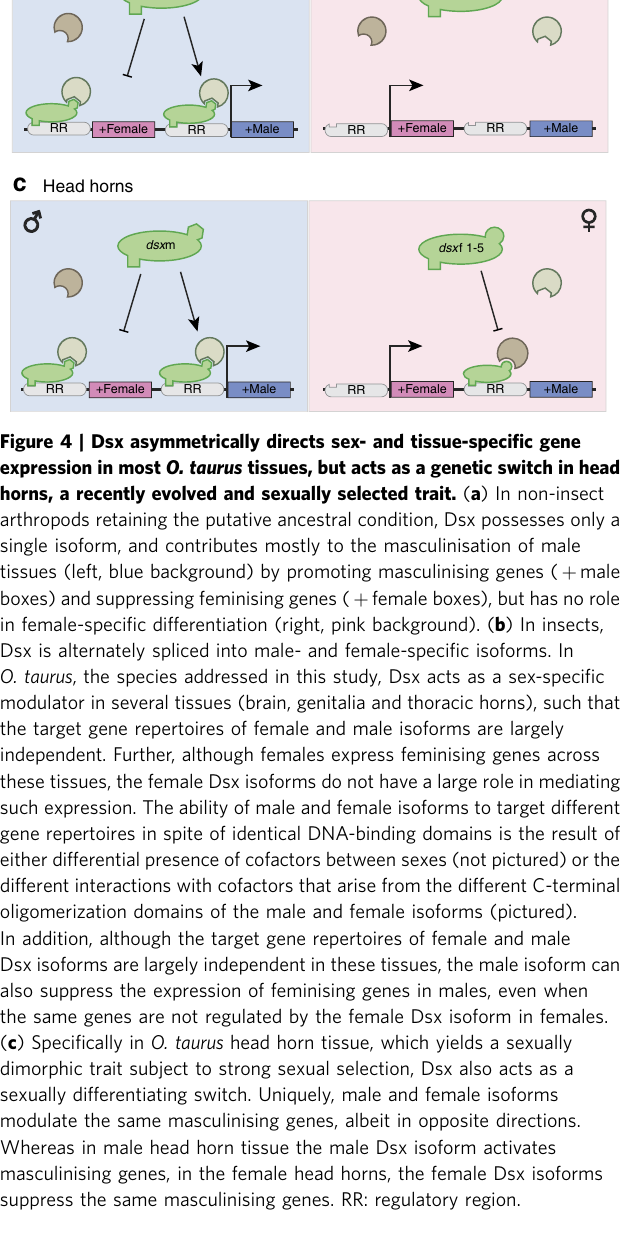
NATURE COMMUNICATIONS|8:14593|DOI: